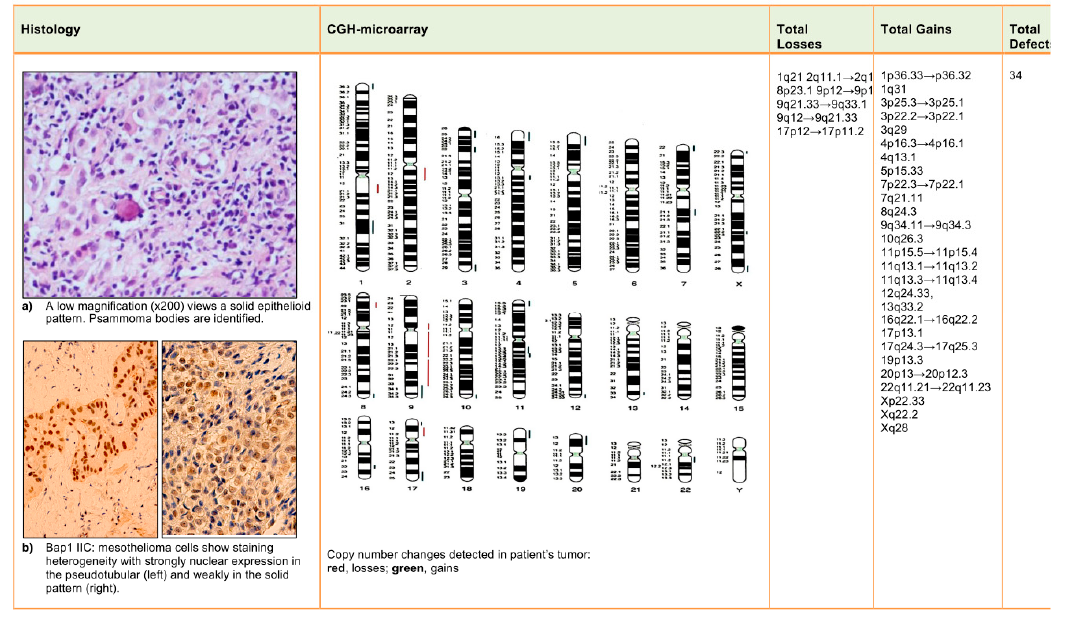
Figure 1. Malignant peritoneal mesothelioma: histology, immunohistochemical (IHC) and comparative genomic hybridization (CGH)-array results.